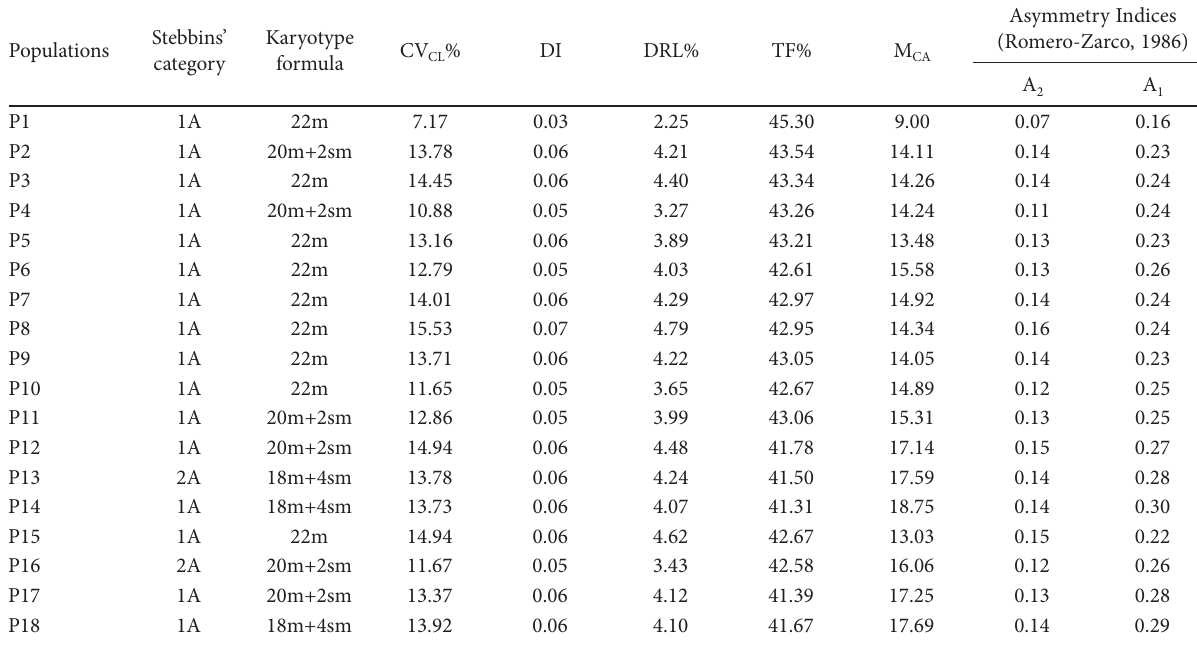
Table 3. Karyotypic parameters of Ferula assa-foetida L. (2 n = 2 x = 22).